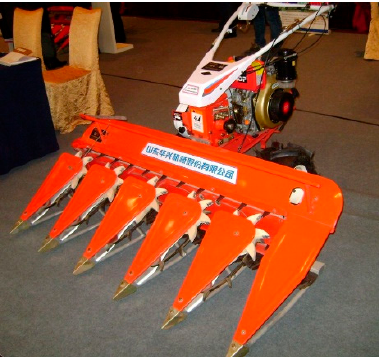
Figure 5. Huaxing cereal harvester mounted on a 4 kW (5.4 hp) 2 WT. (Photo: Brian Sims).